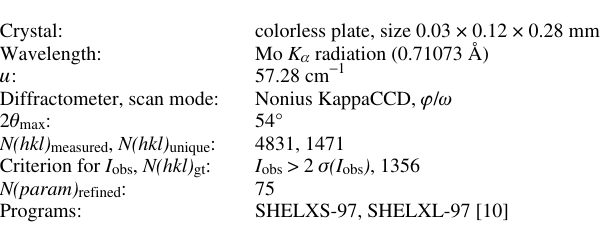
Table 1. Data collection and handling.